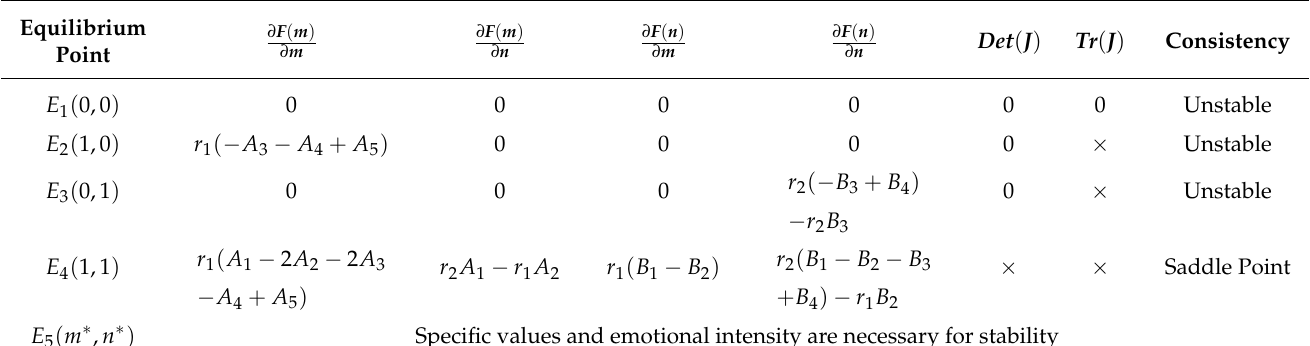
Table 4. Analysis of the stability of the strategy portfolio under various scenarios, including the attitudes of regulators and consumers of energy.